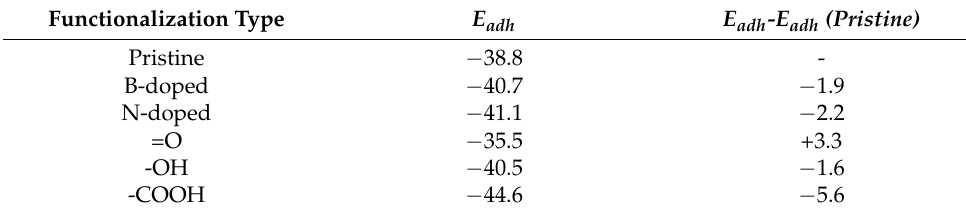
Figure 6. Found relaxed geometries for a single base Zn-salphen compound adsorbed to a pristine graphene ( a ), as well as boron ( b ) and nitrogen ( c ) substituted, oxidized ( d ) and functionalized with hydroxyl ( e ) and carboxyl ( f ) groups. Annotations in ( e ) and ( f ) show hydrogen bond lengths. Table 1. Ab initio energy of adhesion (kcal/mol).